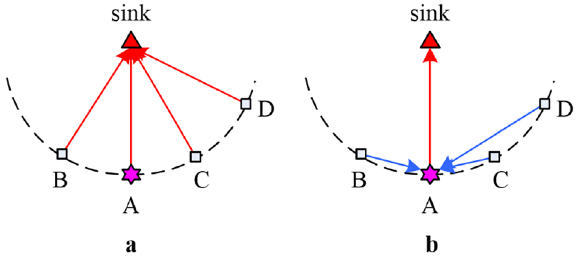
Figure 2. Comparison of energy consumption in non-clustering and clustering